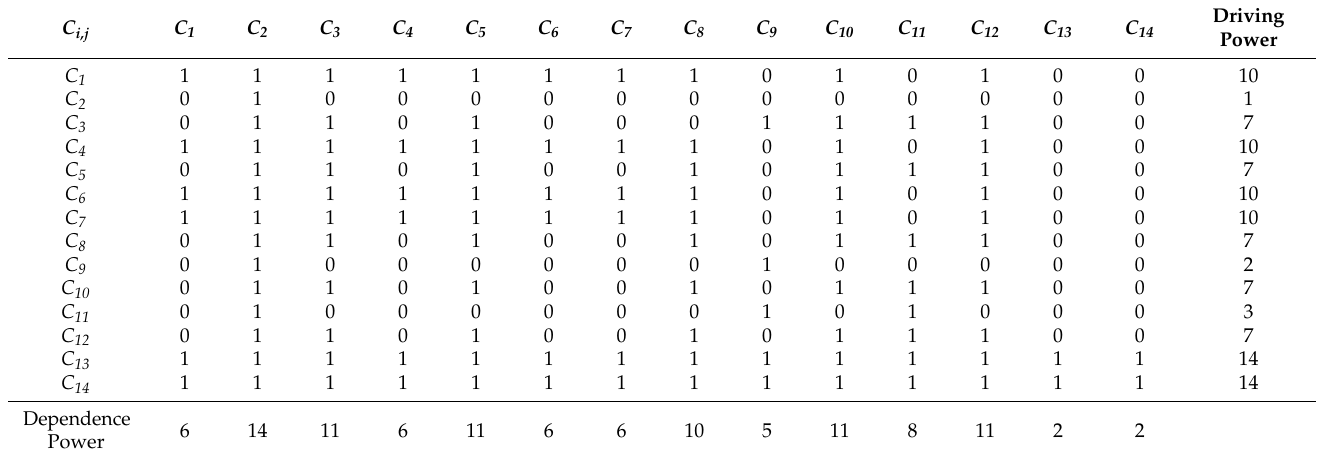
Table 4. Initial Reachability Matrix (IRM) of critical Systems-Thinking-based leadership competencies as enablers to better construction safety performance.